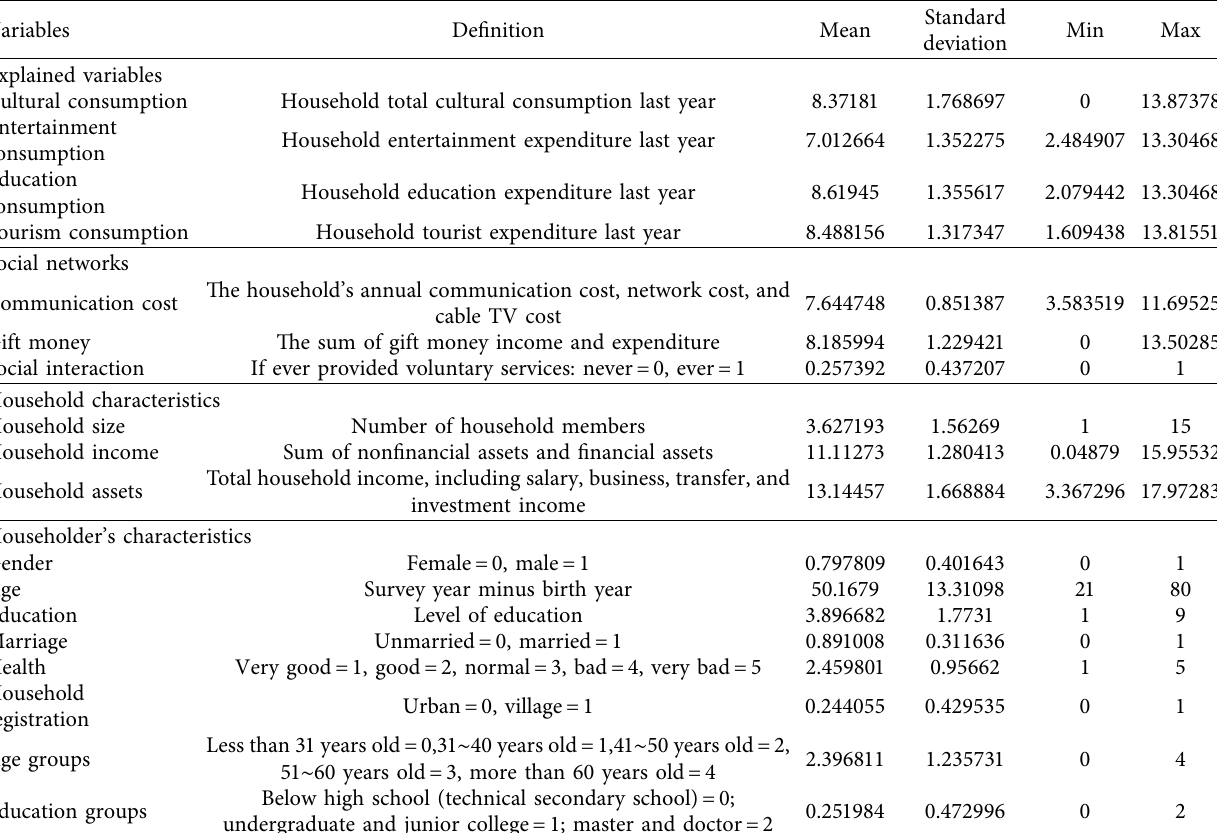
Table 1: Definition of variables and descriptive